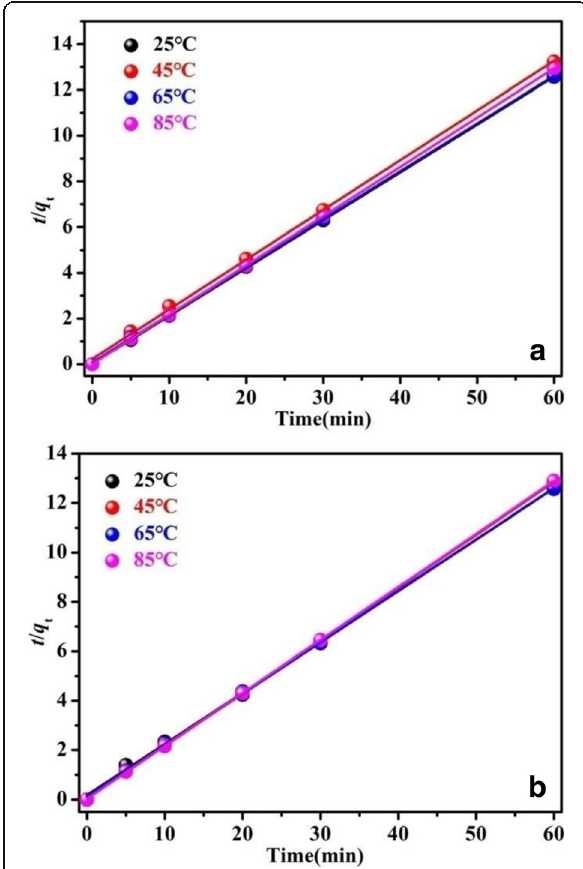
Fig. 12 Pseudo-second-order kinetics for adsorption RhB on BiOCl ( a ) and Fe/BiOCl ( b )